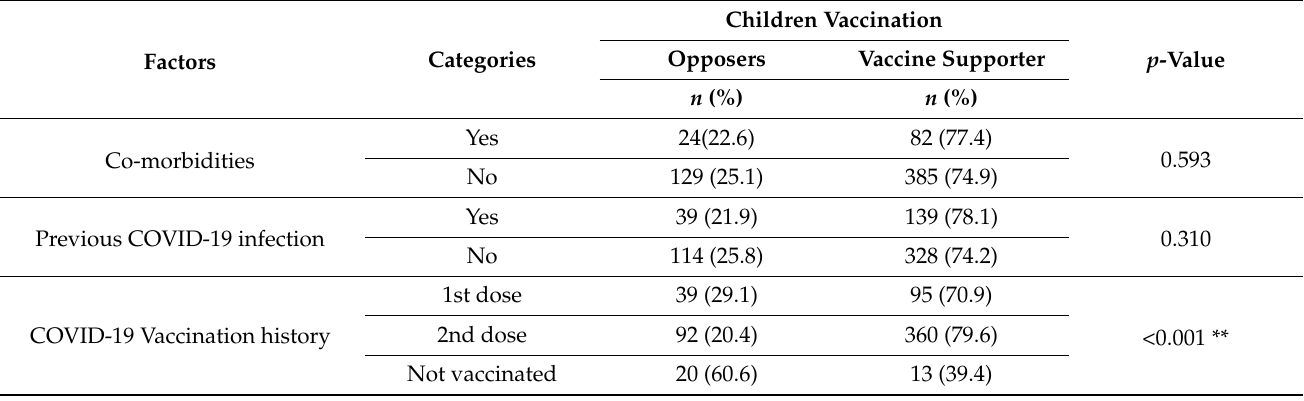
Table 4. Association between factors related to COVID-19 and participants’ attitudes